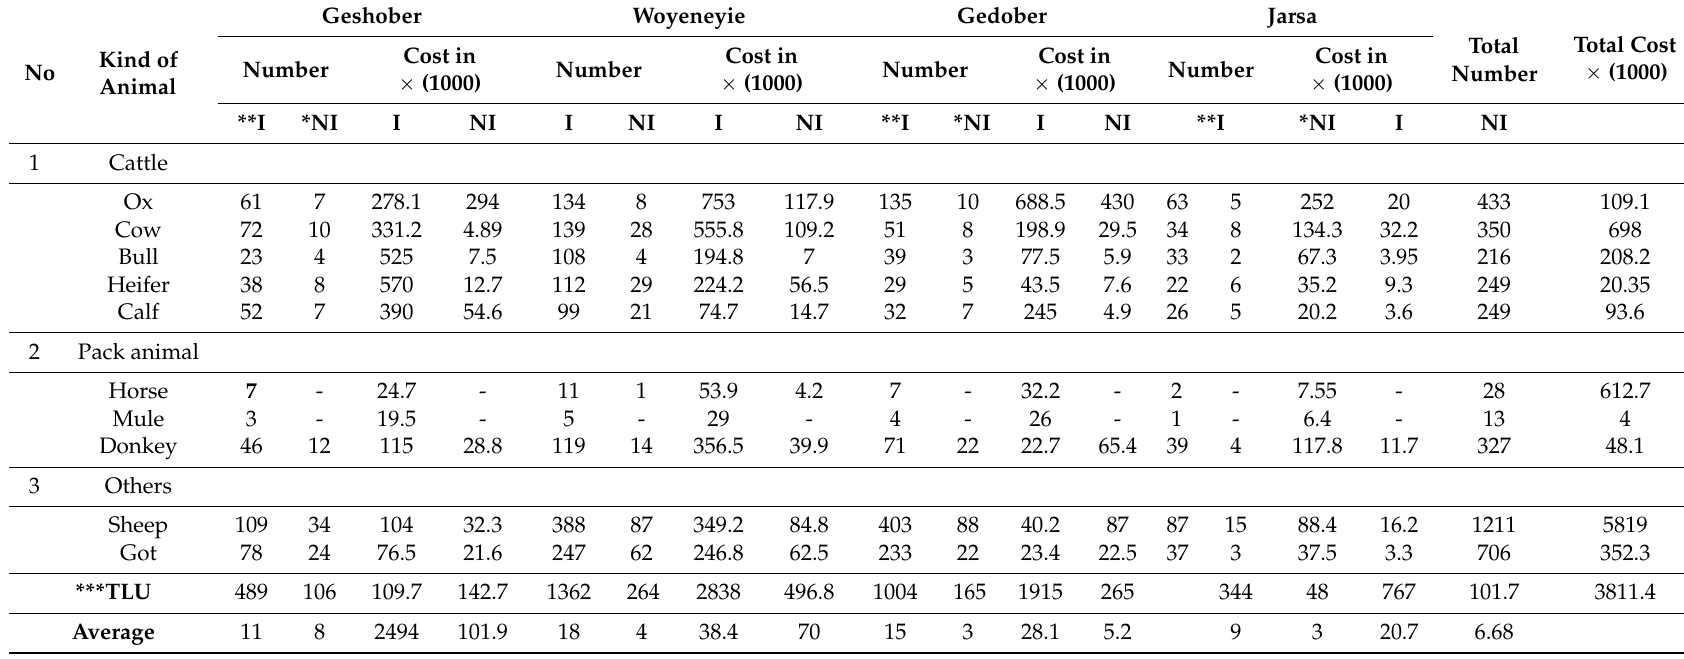
Table 3. Total livestock population and current cost of SSI schemes in